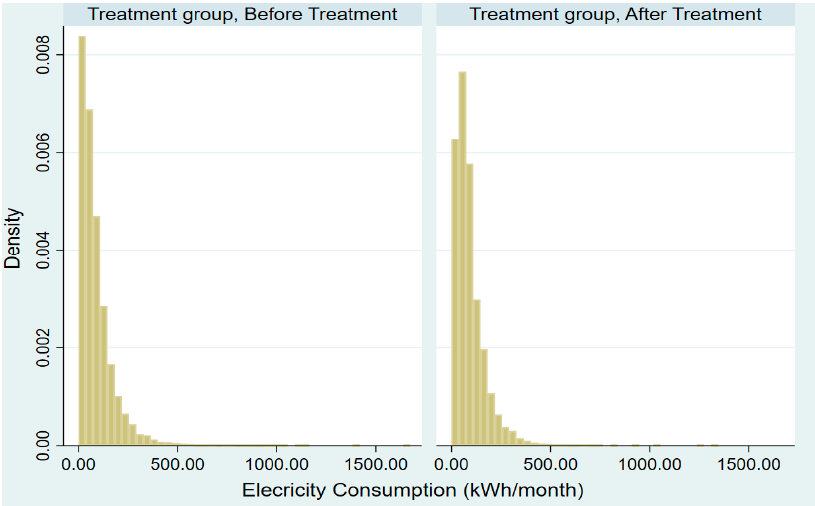
Figure 3. Histogram of electricity consumption by month of the treatment, before and after the treatment. Table 5. Quantile difference-in-differences (DID) regression